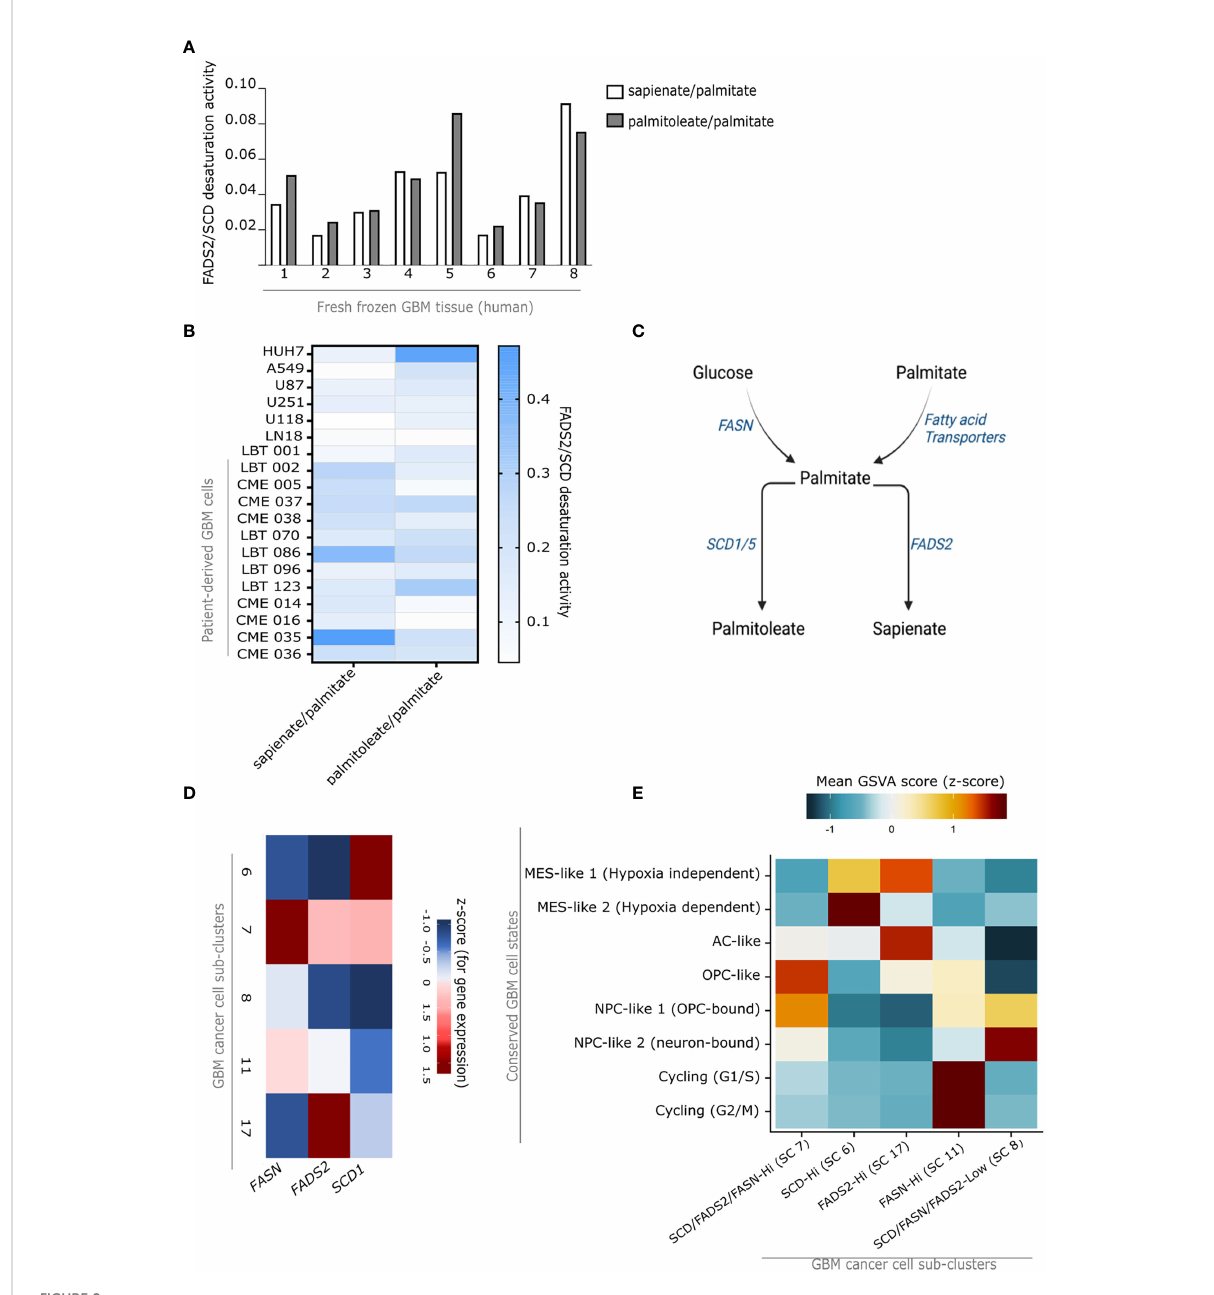
FIGURE 2 Fatty acid metabolism in GBM cancer cells is linked to cell fate. (A) Desaturation activity of SCD (palmitate-to-palmitoleate ratio) and FADS2 (sapienate-to-palmitate ratio) in fresh frozen GBM tissue from eight patients (patient details in Supplementary Table S2). (B) Desaturation activity of SCD (palmitate-to-palmitoleate ratio) and FADS2 (sapienate-to-palmitate ratio) in human cell lines: hepatocellular carcinoma (HUH7), lung adenocarcinoma (A549), immortalized GBM cells (U87, U251, U118, LN18) and patient-derived GBM cell lines (LBT 001, LBT 002, CME 005, CME 037, CME 038, LBT 070, LBT 086, LBT 096, LBT 123, CME 014, CME 016, CME 035, CME 036) (patient details corresponding to cell lines in Supplementary Table S1). Color scale represents mean desaturation activity (n=3). HUH7, U87, U251, LN18, U118 were cultured in 1% FBS medium, A549 cells were cultured in 0.5% FBS medium. Patient-derived GBM cells were cultured in NSA medium without FBS. (C) Brief overview of the fatty acid mono-desaturation pathway. (D) Average gene expression levels of FASN , SCD1 and FADS2 in cancer cell sub-clusters of interest (SC: 6, 7, 8, 11, 17) among those in Figure 1B. The color scale indicates Z-scores, based on the overall mean expression level (and associated standard deviation) for each gene across all sub-cluster. (E) GSVA scores for gene sets representing different GBM cell fates in cancer cell sub-clusters of interest (SC: 6, 7, 8, 11, 17) among those in Figure 1B. The color scale indicates Z-scores, based on the overall mean GSVA score (and associated standard deviation) for each gene set across all sub-clusters. MES, mesenchymal; AC, astrocytic cells; OPC, oligodendrocytic precursor cell; NPC, neuronal progenitor